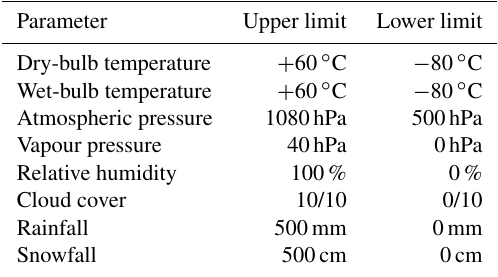
Table 2. For each meteorological parameter, upper and lower phys- ical limits used in gross error test are listed.